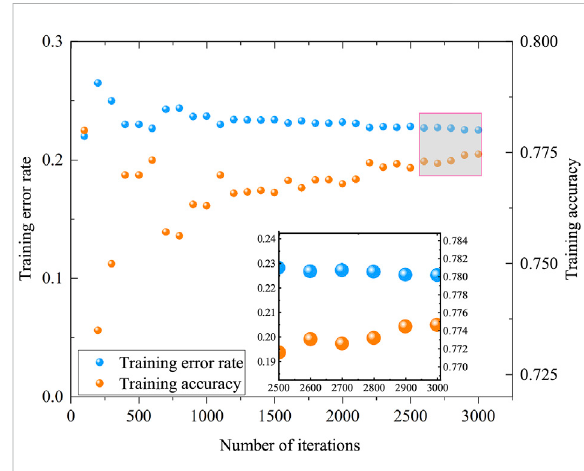
FIGURE 4 The number of training times corresponds to the function of training error rate and training accuracy. The horizontal axis represents the number of training times, and the vertical axis represents the training error rate and accuracy rate. Training error and accuracy are marked in blue and orange, respectively. For accurate viewing, zoom plots are set to make it easier to observe the